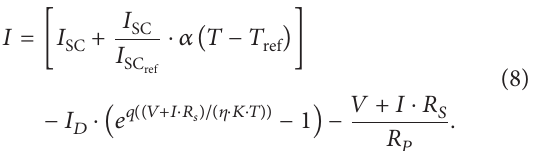
Figure 6: 𝑃 × 𝑉 curve for different values of solar irradiance.